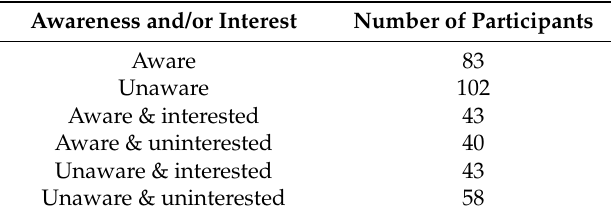
Table 2. Interest and awareness in the initiative.